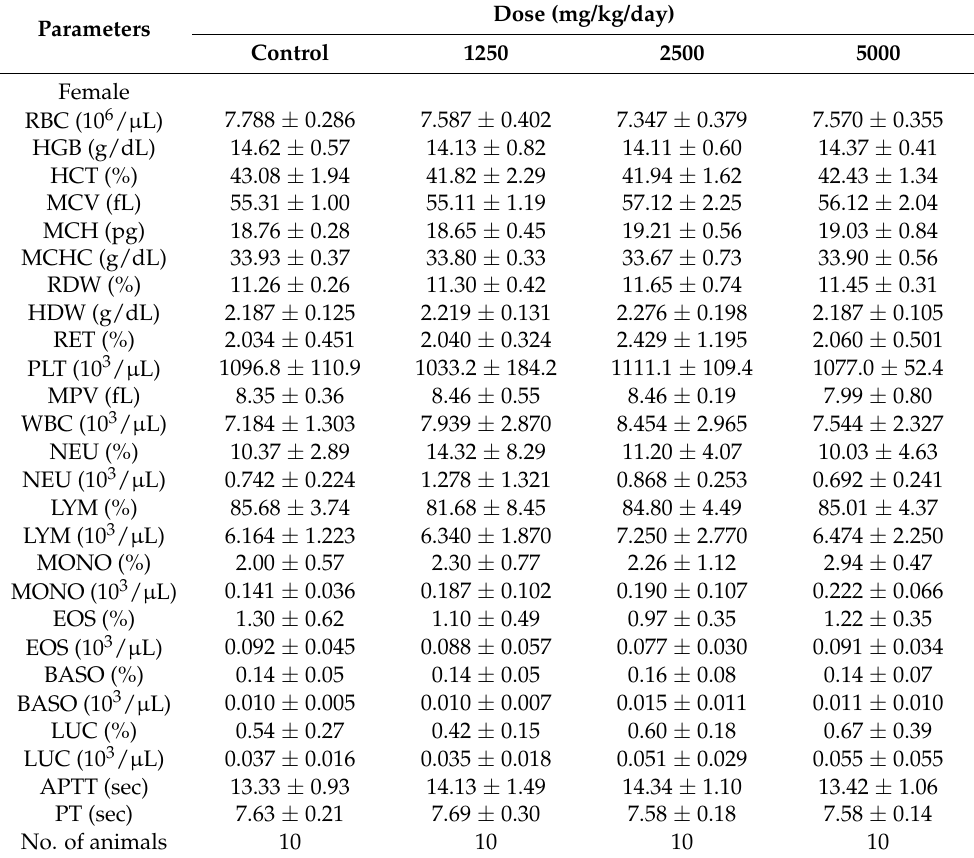
Table 8. Hematology values in 13 weeks repeated oral dose toxicity of WG extract in female